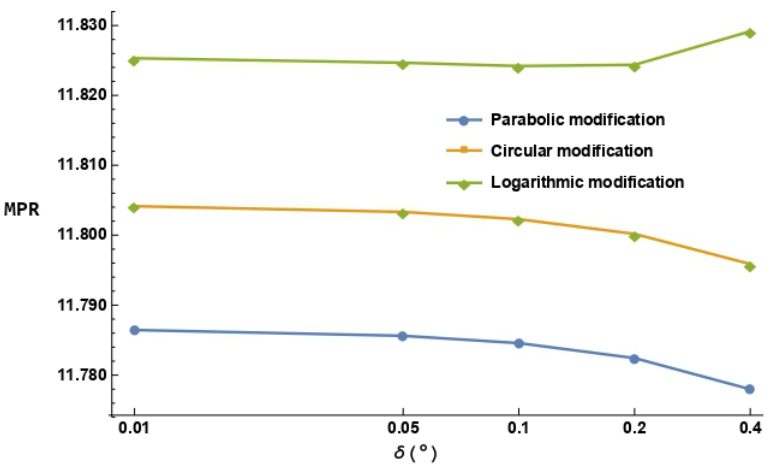
Figure 14. The maximum contact pressure ratio ( MPR ) versus the amount of out-of-plane misalign- ment of spur gears with three types of modification. In Figure 15, the contact path and the contact ellipses for a spur gear with a circular crowning and an out-of-plane misalignment of 0.01 ◦ (0.17 mrad) are presented as a repre- sentative example. It can be seen that the MPR in the lower part of the gear tooth is greater than in the upper part but reaches its peak around the center of the surface. Additionally, with each point of the contact path starting from the top, the MPR increases to a peak before it begins to decrease until the lowest point.